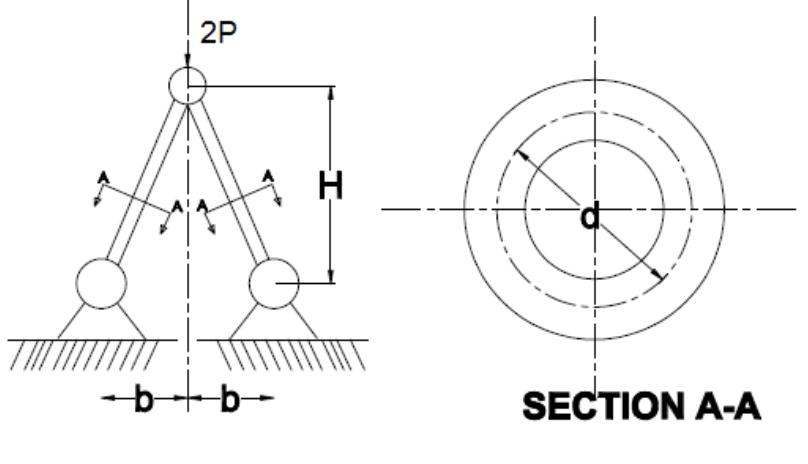
Fig. 1. Two bar truss under